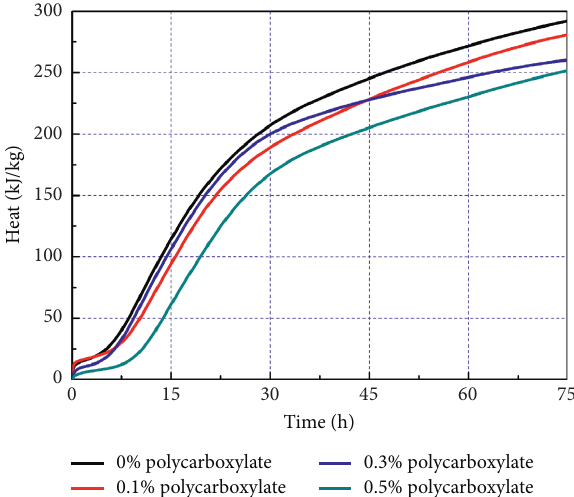
Figure 4: Effect of PCE-2 dosage on hydration heat of cement pastes.